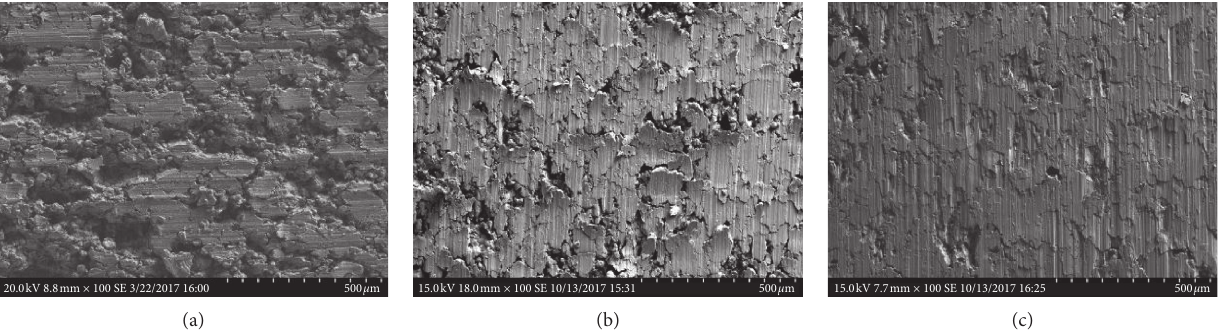
Figure 6: Machined surface morphologies machined at rounded edge radius of (a) 20 μ m, (b) 40 μ m, and (c) 120 μ